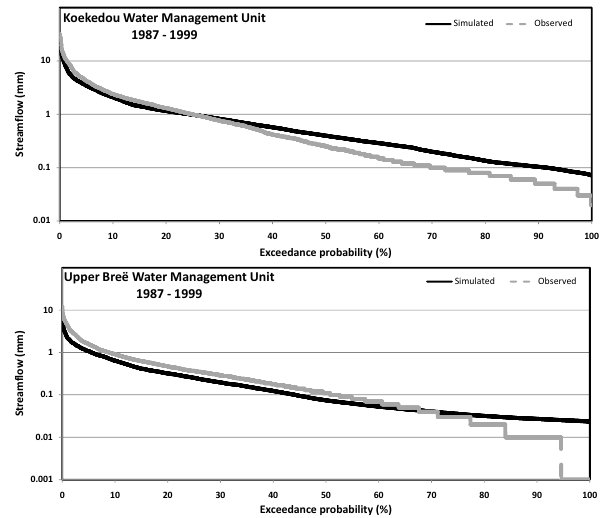
Fig. 12. Comparison of flow duration curves of daily simulated and observed streamflows for (from top to bottom) the Koekedou WMU and the Upper Bre¨e WMU of the Upper Breede